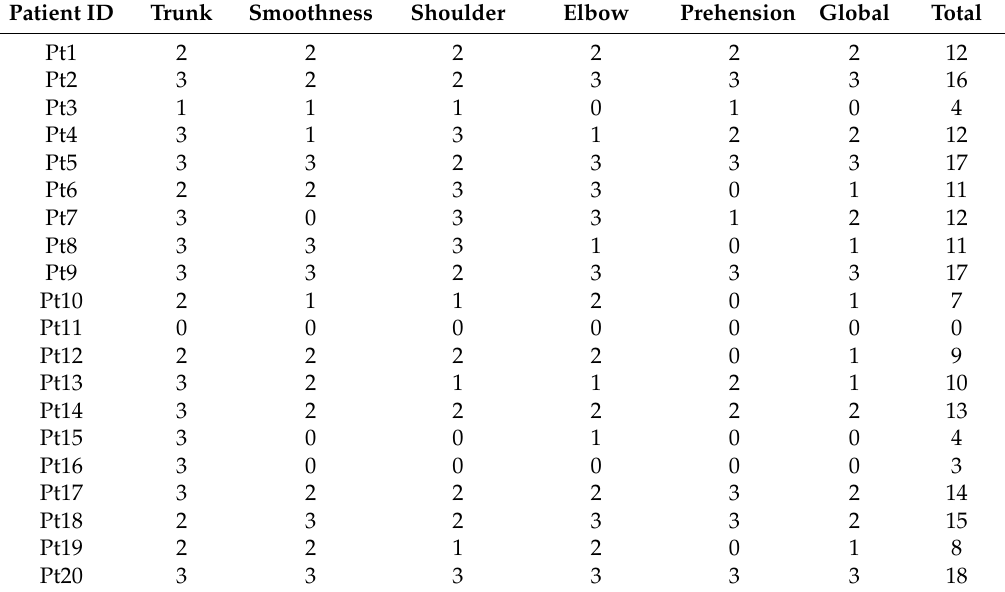
Table 3. Summary of the reaching performance scale scores.